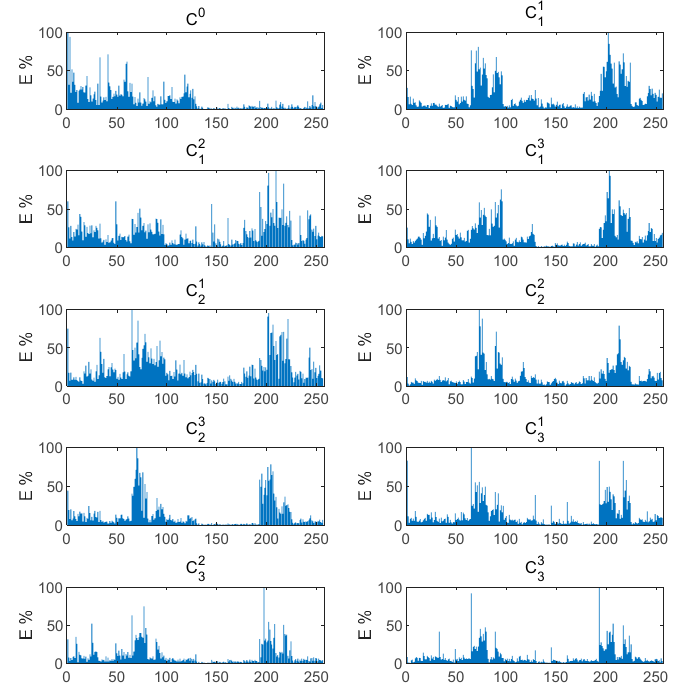
Figure 9. WPT decomposition branch signal of normal bearing vibration signal.